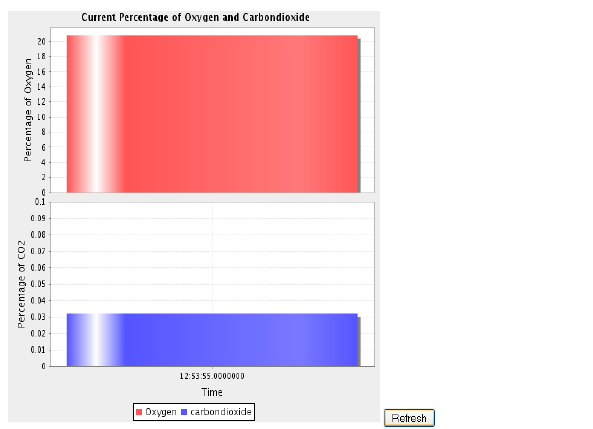
Figure 8. Visualization of percentage of oxygen and carbon-dioxide for the current instance of time